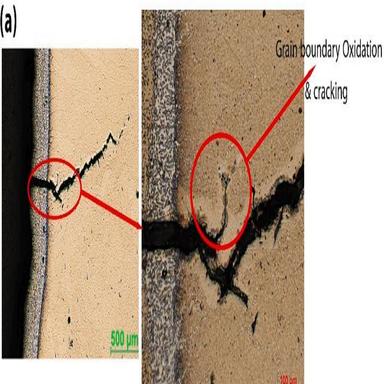
Optical micrograph of the cooling hole after 55,000 h of service exposure at the 25% airfoil height.